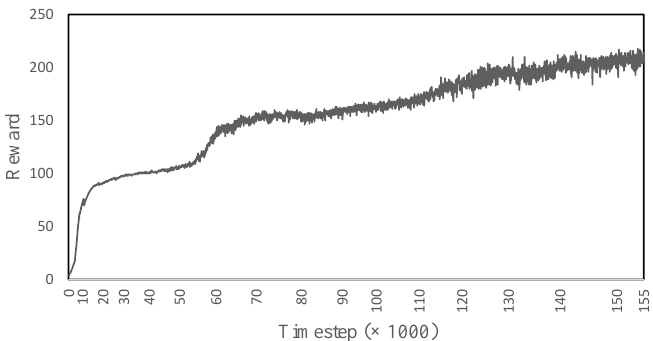
Figure 5. The reward obtained during the learning process of the human musculoskeletal model to ascend the